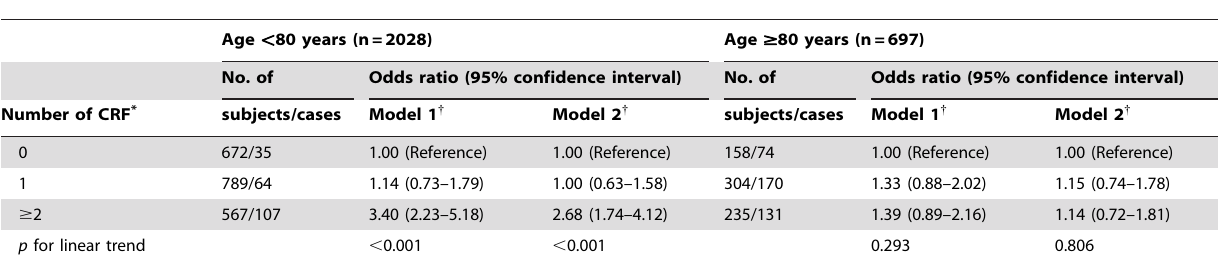
Table 4 . Odds ratios (95% confidence interval) of mobility limitation associated with clustering of CRFs by age.